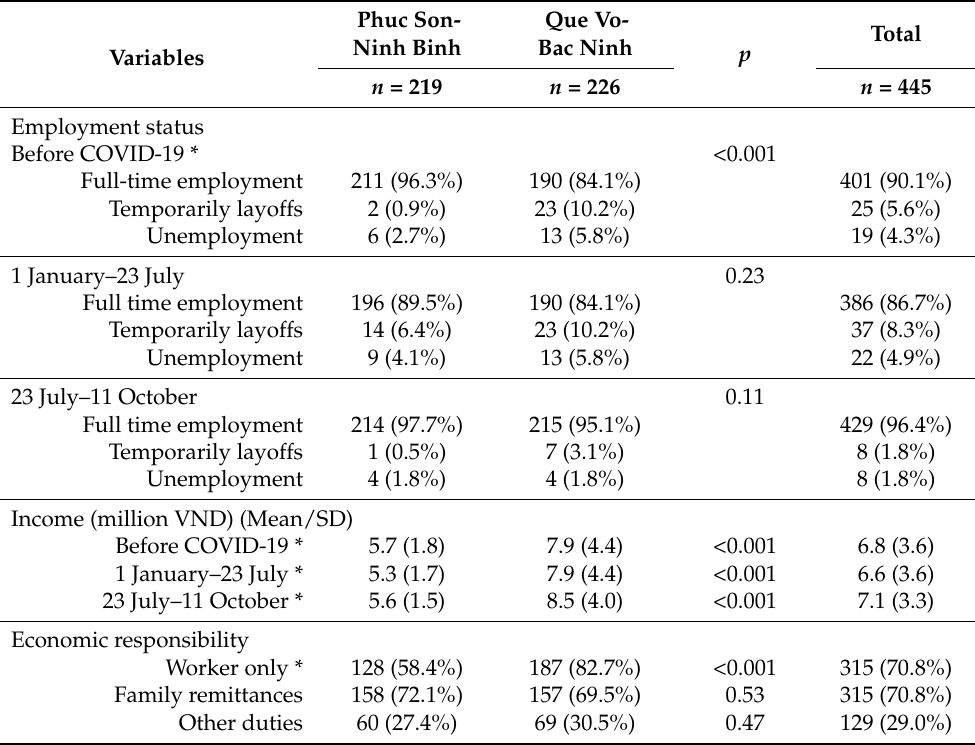
Table 5. Migrant workers’ employment, salary and economic responsibilities.